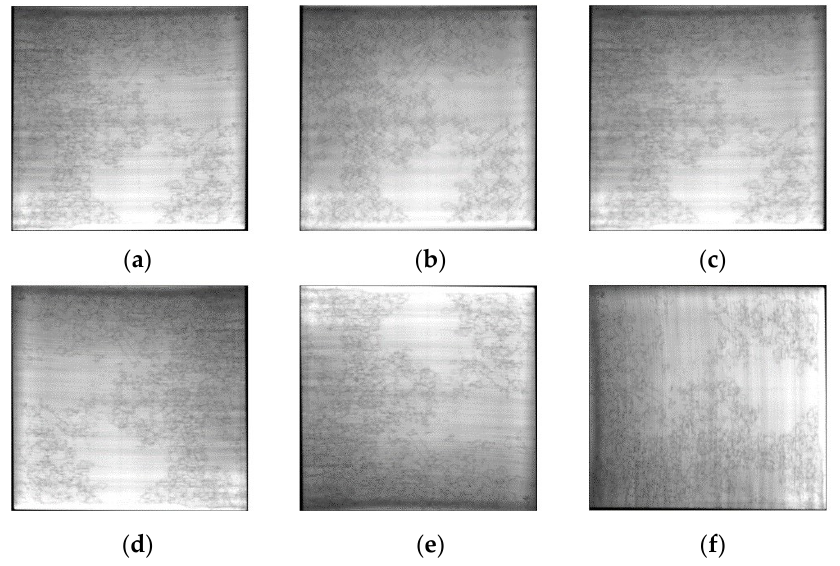
Figure 2. Schematic diagram of data enhancement: ( a ) original image, ( b ) frequency domain filtering, ( c ) spatial domain filtering, ( d ) horizontal mirroring, ( e ) vertical mirroring, and ( f ) random rotation.